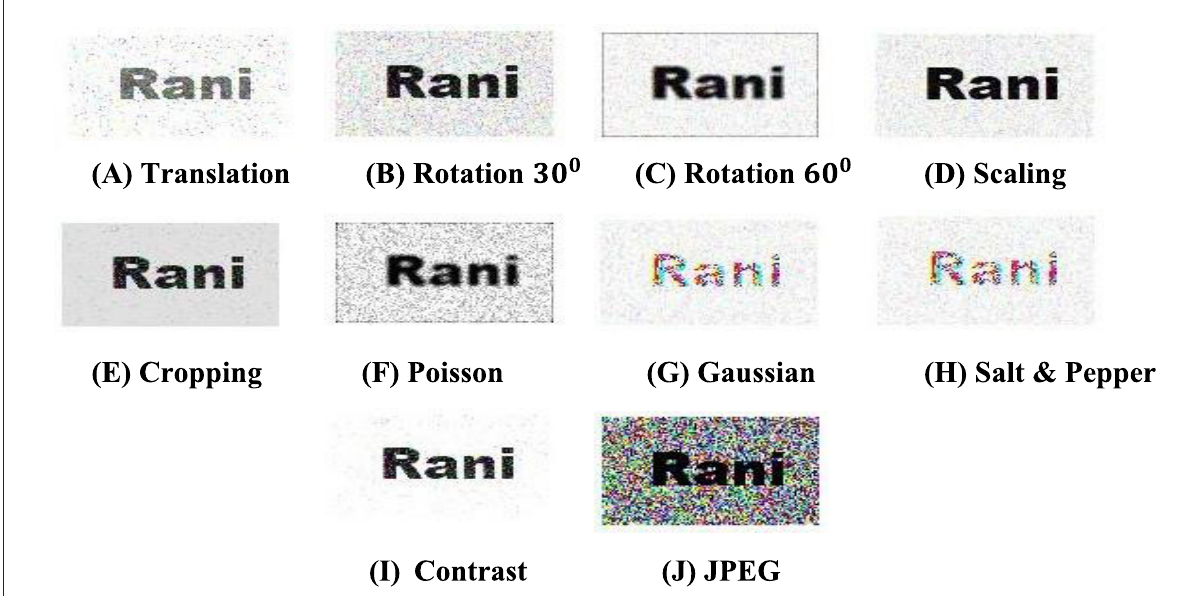
FIGURE10 Schematic representation of extracted watermark after performing some geometric attacks. (A) Translation. (B) Rotation 30 0 . (C) Rotation 60 0 . (D) Scaling. (E) Cropping. (F) Poisson. (G) Gaussian. (H) Salt and Pepper. (I) Contrast. (J)